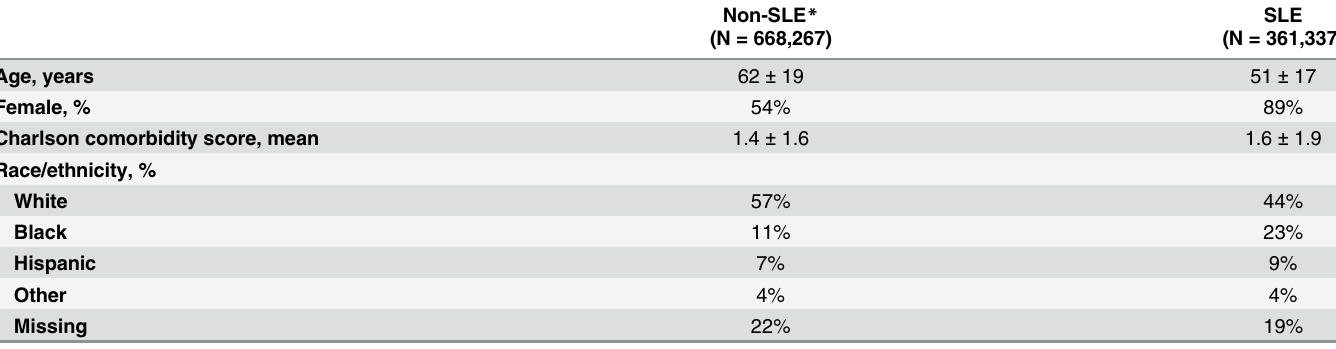
Table 1. Characteristics of SLE and non-SLE hospitalizations in the National Inpatient Sample, between years 2000 and 2011.